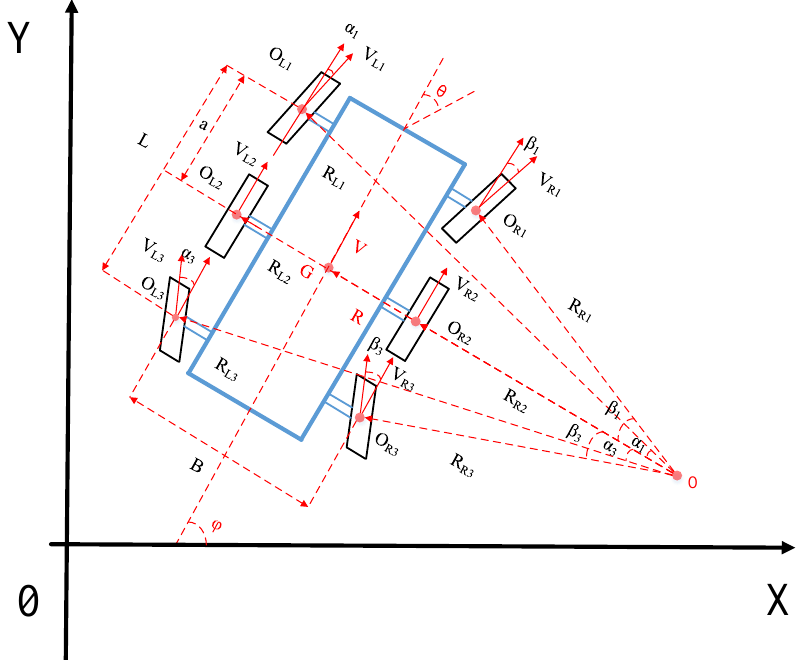
Figure 1. Six-wheel distributed unmanned vehicle path-tracking kinematic model.